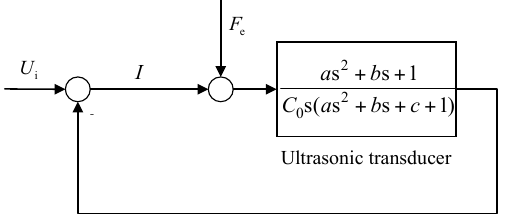
Figure 9. The closed-loop system of ultrasonic transducer.